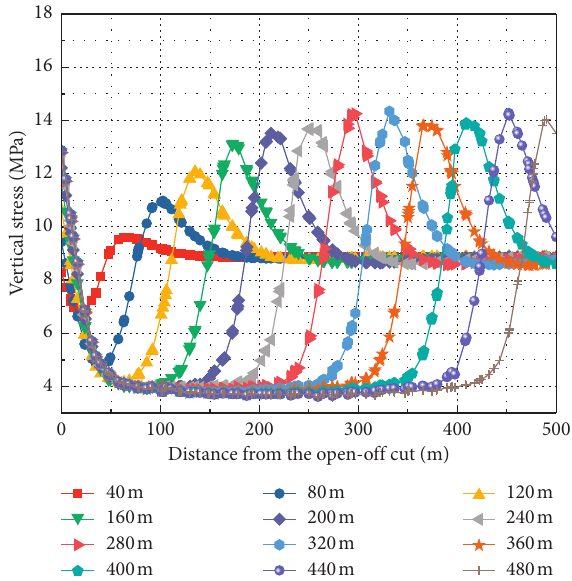
Figure 8: Evolution rule of mining stress in the protected layer of #3 coal seam.